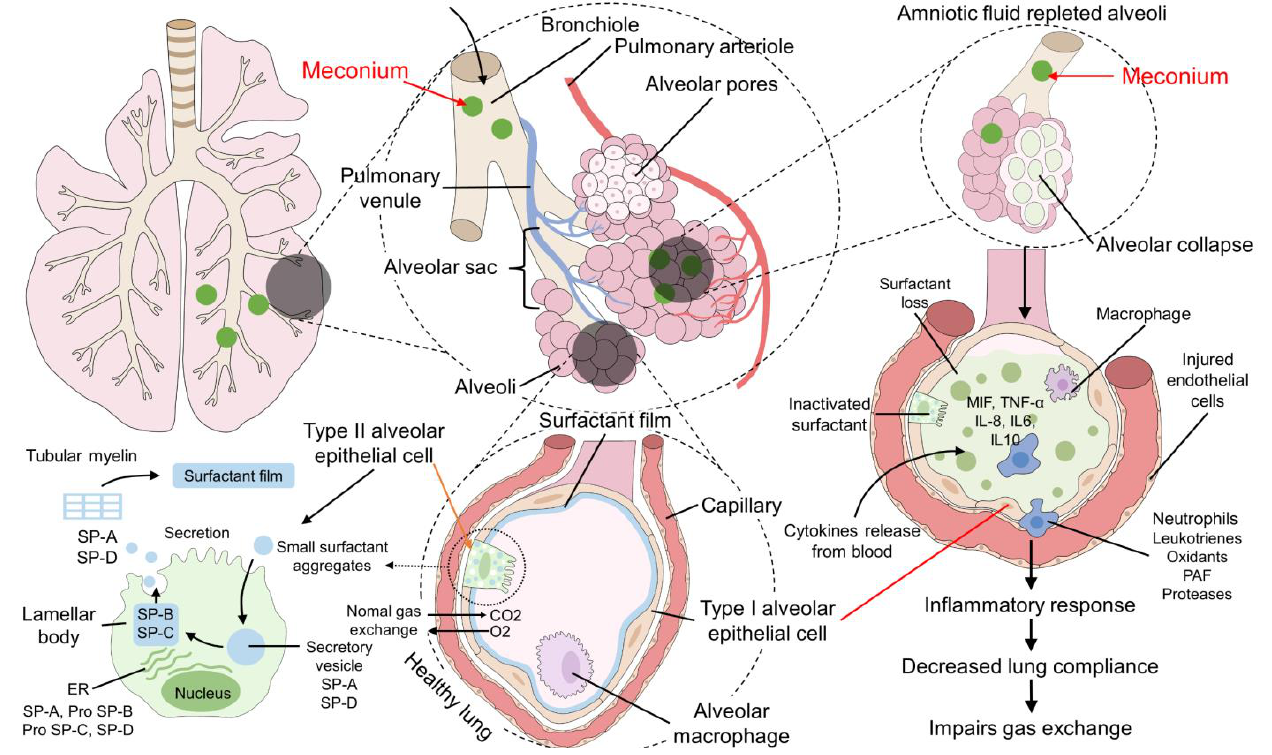
Figure 5. Surfactant inactivation in Meconium Aspiration Syndrome. In a healthy lung, the surfactant film is produced by the type II alveolar epithelial cells (pneumocyte type II) in their lamellar bodies, and this film prevents alveolar collapse. However, when meconium-stained amniotic fluid covers the alveoli, type II alveolar cells are not able to produce surfactant, and the presence of proinflammatory cytokines (e.g., MIF, TNF, IL) promotes the inflammatory response in the lung, as well as a decreased lung compliance, atelectasis, and impairment of the gas exchange, resulting in neonatal hypoxia and acidosis. IL: interleukin; MIF: macrophage inhibitor factor; SP: surfactant protein; TNF: tumor necrosis factor.